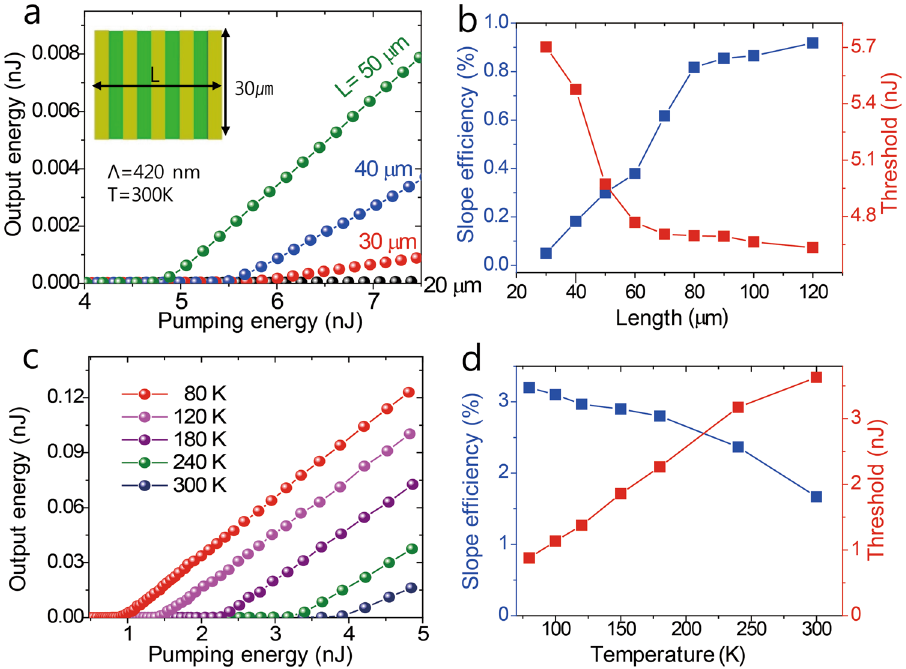
Figure 4. Temperature and grating length dependence. ( a ) Output versus pumping energy curves obtained from grating structures with a fixed period of Λ = 420 nm and a length varying from 20 to 50 μ m. ( b ) Lasing efficiencies (blue) and threshold energies (red) for different grating lengths. ( c ) Temperature-dependent performance of a device with Λ = 420 nm. ( d ) Lasing efficiency (blue) and threshold energy (red) as a function of sample temperature.